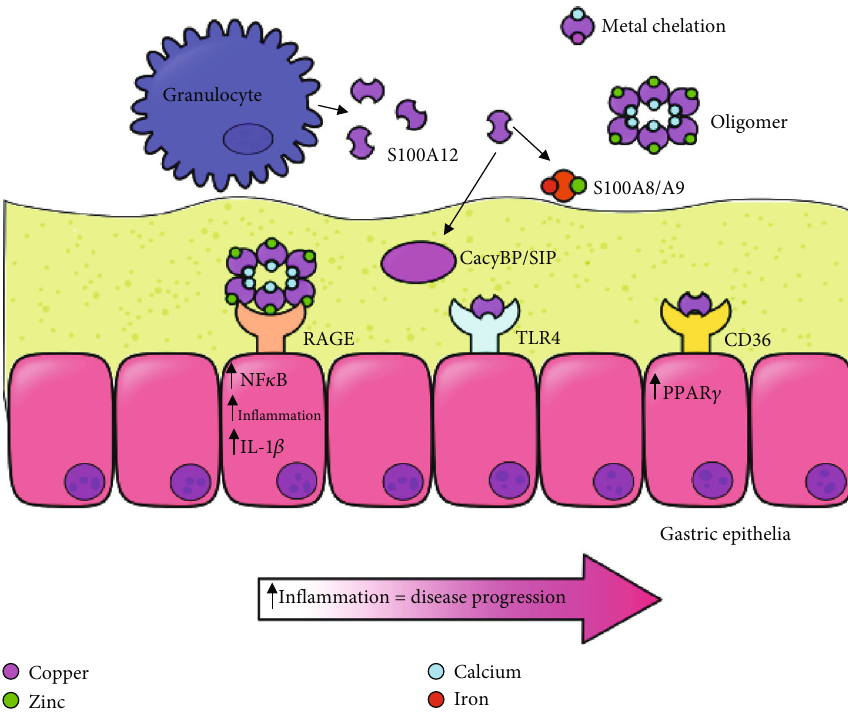
Figure 2: Conceptual diagram of the association of S100A12 in various digestive diseases and health. S100A12 (EN-RAGE or calgranulin C, depicted in a dimer form) is produced by innate immune cells such as granulocytes and participates in the chemotaxis of innate immune cells. It can exist as a dimer or oligomer and can bind divalent cations including zinc, copper, and calcium to promote “ nutritional immunity ” against invading microbial pathogens. S100A12 interacts with cell surface membranes as well as RAGE, TLR4, and CD36 receptors to promote proin fl ammatory signaling and disease progression. S100A12 also interacts with CacyBP/SIP and S100A9. S100A12 binding of calcium and zinc enhances oligomerization and interactions with receptors such as RAGE.